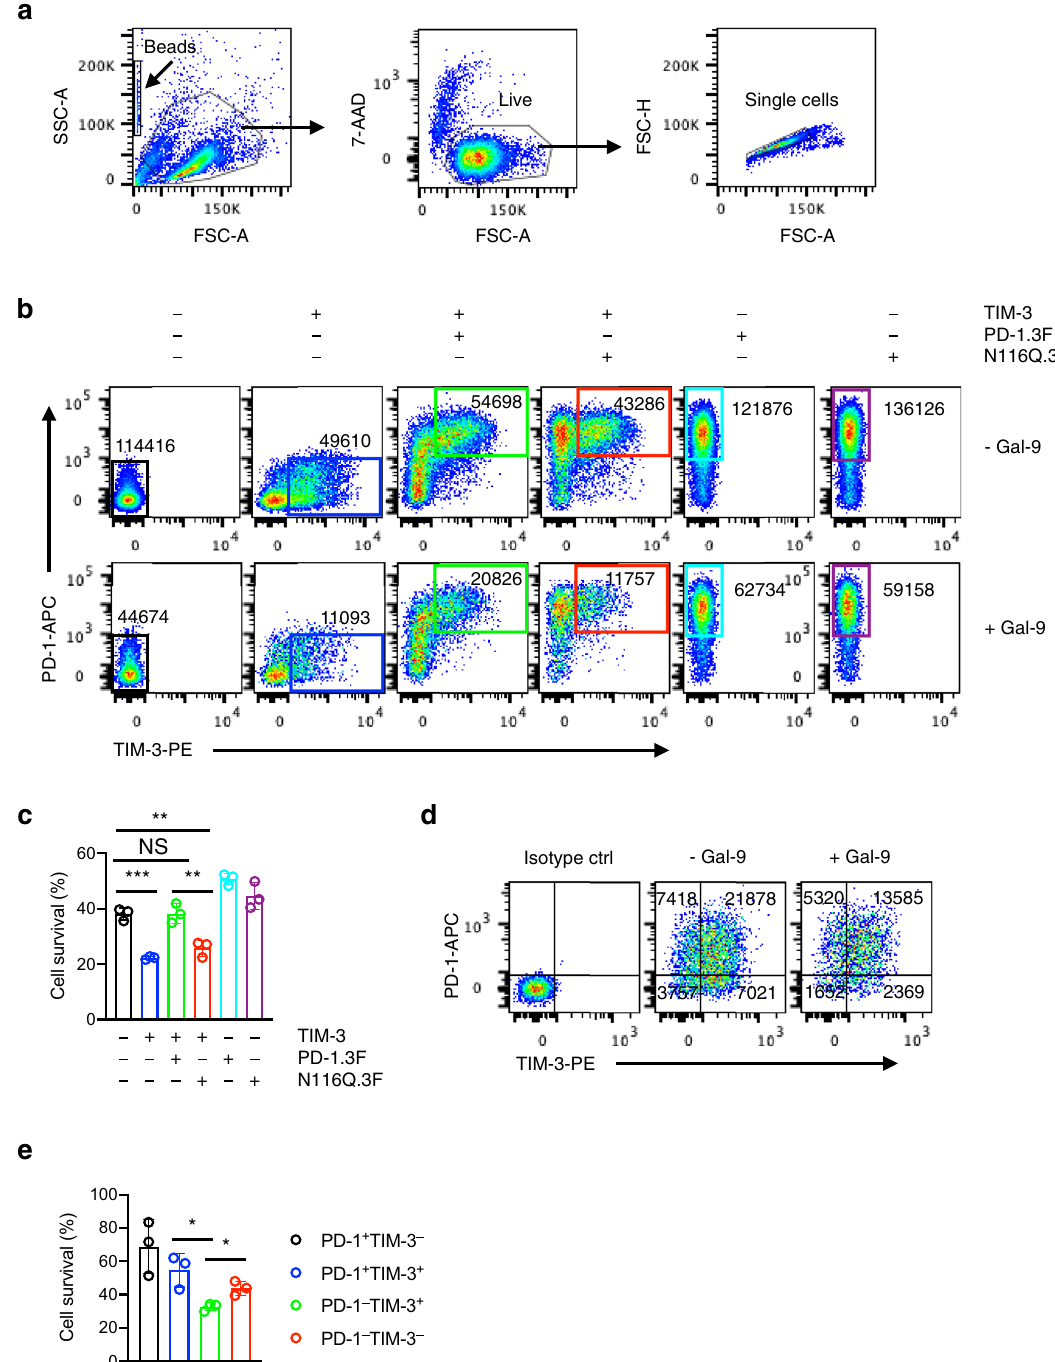
Fig. 4 Co-expressed PD-1 protects TIM-3 + T cells from Gal-9-induced cell death. a – c Jurkat cells transduced with indicated proteins individually or in combinations were treated with or without Gal-9 for two days and stained with PD-1/TIM-3 antibodies. Cell survival of relevant PD-1/TIM-3 subsets was determined by fl ow cytometry with counting beads. a Cells were gated based on FSC/SSC parameters and 7-AAD staining. b , c Viable single cells equivalent to 3000 counting beads are shown in plots for each sample (10,000 beads were added to each sample just prior to data acquisition). Numbers in plots indicate cell count in corresponding gates. Data (mean values ± SD) from three independent experiments are shown ( c ). Two-tailed unpaired t -test. NS, not signi fi cant ( P > 0.05); ** P < 0.01; *** P < 0.001. Control vs TIM-3, P = 0.0003; control vs TIM-3 + PD-1, P = 0.9382; control vs TIM-3 + PD-1 (N116Q), P = 0.0040; TIM-3 + PD-1 vs TIM-3 + PD-1(N116Q), P = 0.0084. d , e Human CD8 T cells were incubated in ImmunoCult-XF T Cell Expansion Medium with or without Gal-9 in the presence of IL-2 and ImmunoCult Human CD3/CD28/CD2 T Cell Activator for 2 days and analyzed by fl ow cytometry with counting beads as described above for the survival of different PD-1/TIM-3 subsets. Numbers in plots indicate cell counts in corresponding quadrants. Data (mean values ± SD) are representative of three independent experiments. Two-tailed unpaired t -test. * P < 0.05. PD-1 – TIM-3 + vs PD-1 + TIM-3 + , P = 0.0212; PD-1 – TIM-3 + vs PD - 1 – TIM-3 – , P = 0.0164. Source data are provided as a Source data fi